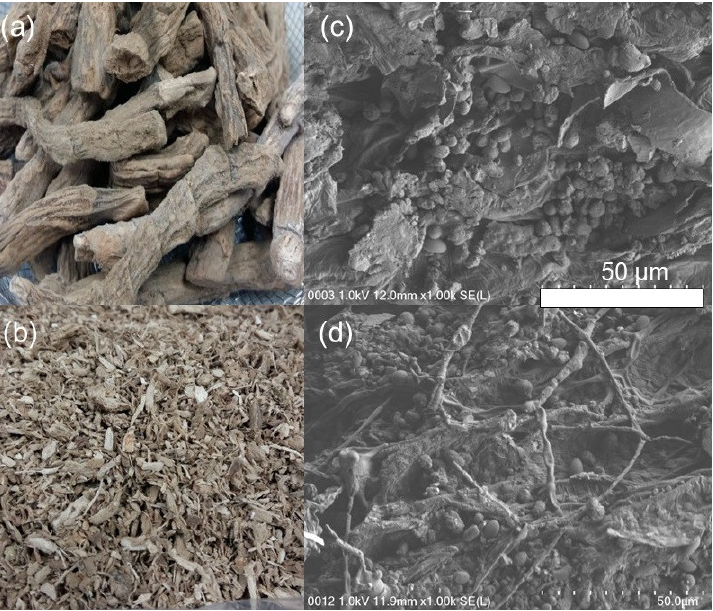
Figure 7. The ( a ) dried and ( b ) ground A. calamus samples. ( c , d ) are the plant matrices with visible structures of fiber and oil glands at 1000× magnification.